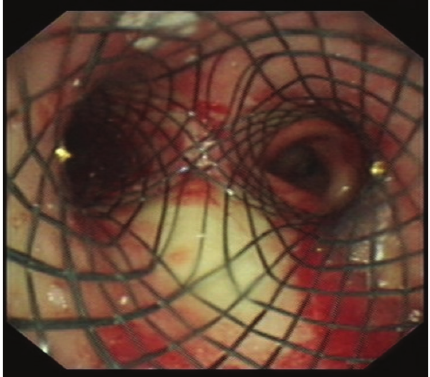
Figure2:Computedtomographyofthechestdepictingthepresence of a bronchoesophageal fistula between the left main bronchus and the esophagus.